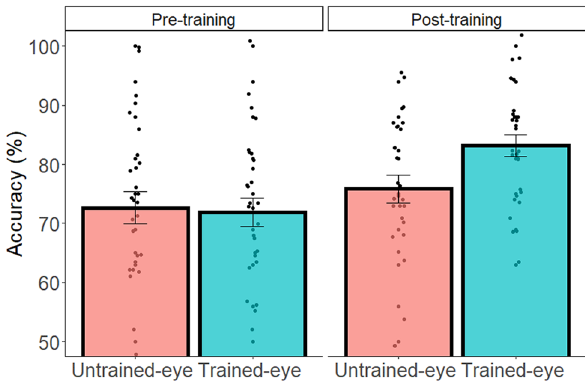
Figure 3. Accuracy for each individual (dot) as a function of Eye and Experimental Stage in novel subtraction problems. Error bars represent SEM.